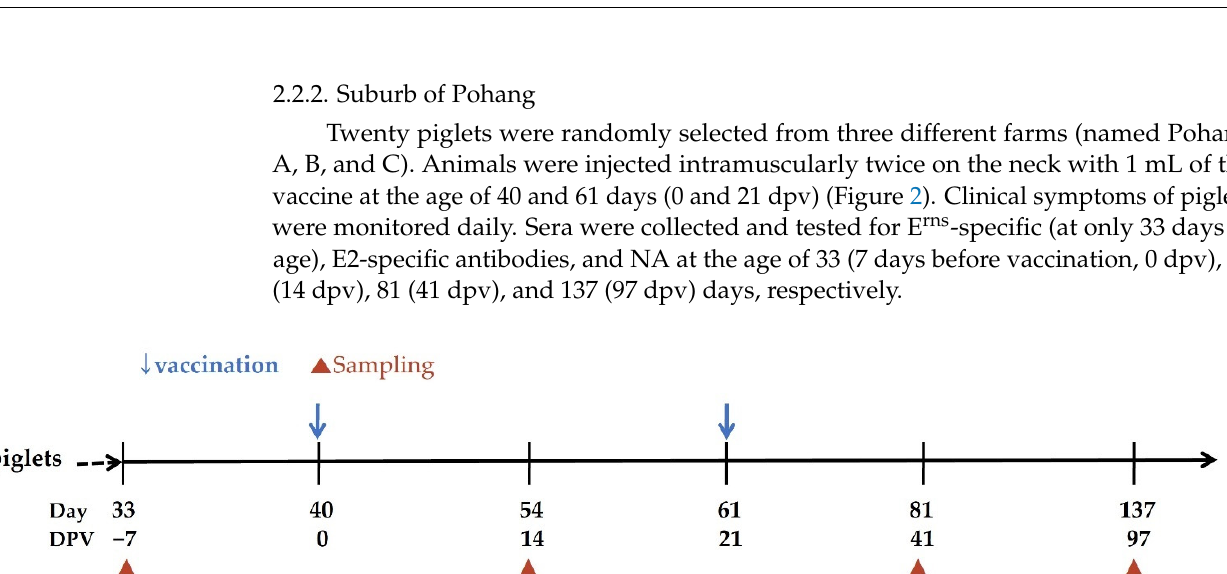
Figure 1. The schematic presentation of Immunization protocols in Jeju Island. ( a ) The timing of blood collection, vaccina- tion, and delivery from pregnant sows and newborn piglets was presented. ( b ) The timing of blood collection and vac- cination from CSF-free piglets was presented.